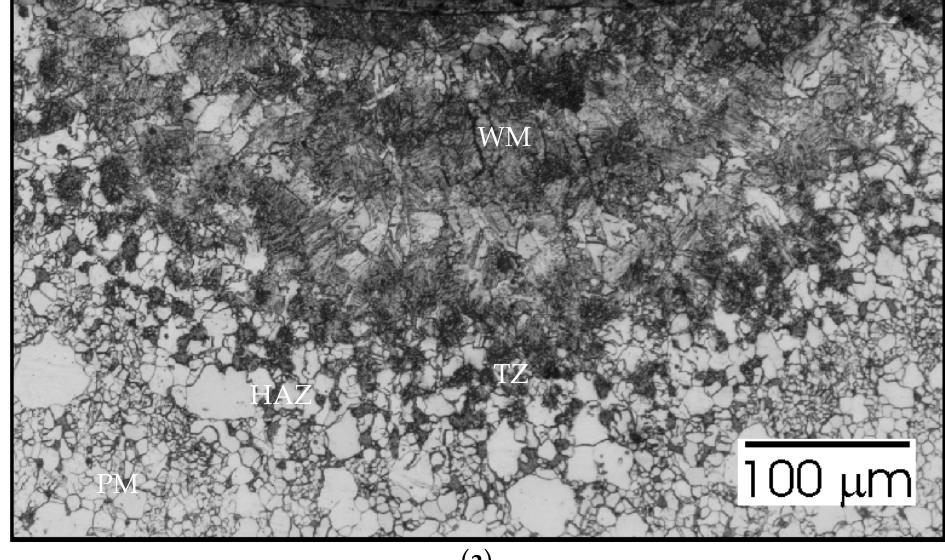
Figure 20. Cooling time t 8/5 depending on the ambient temperature T 0.